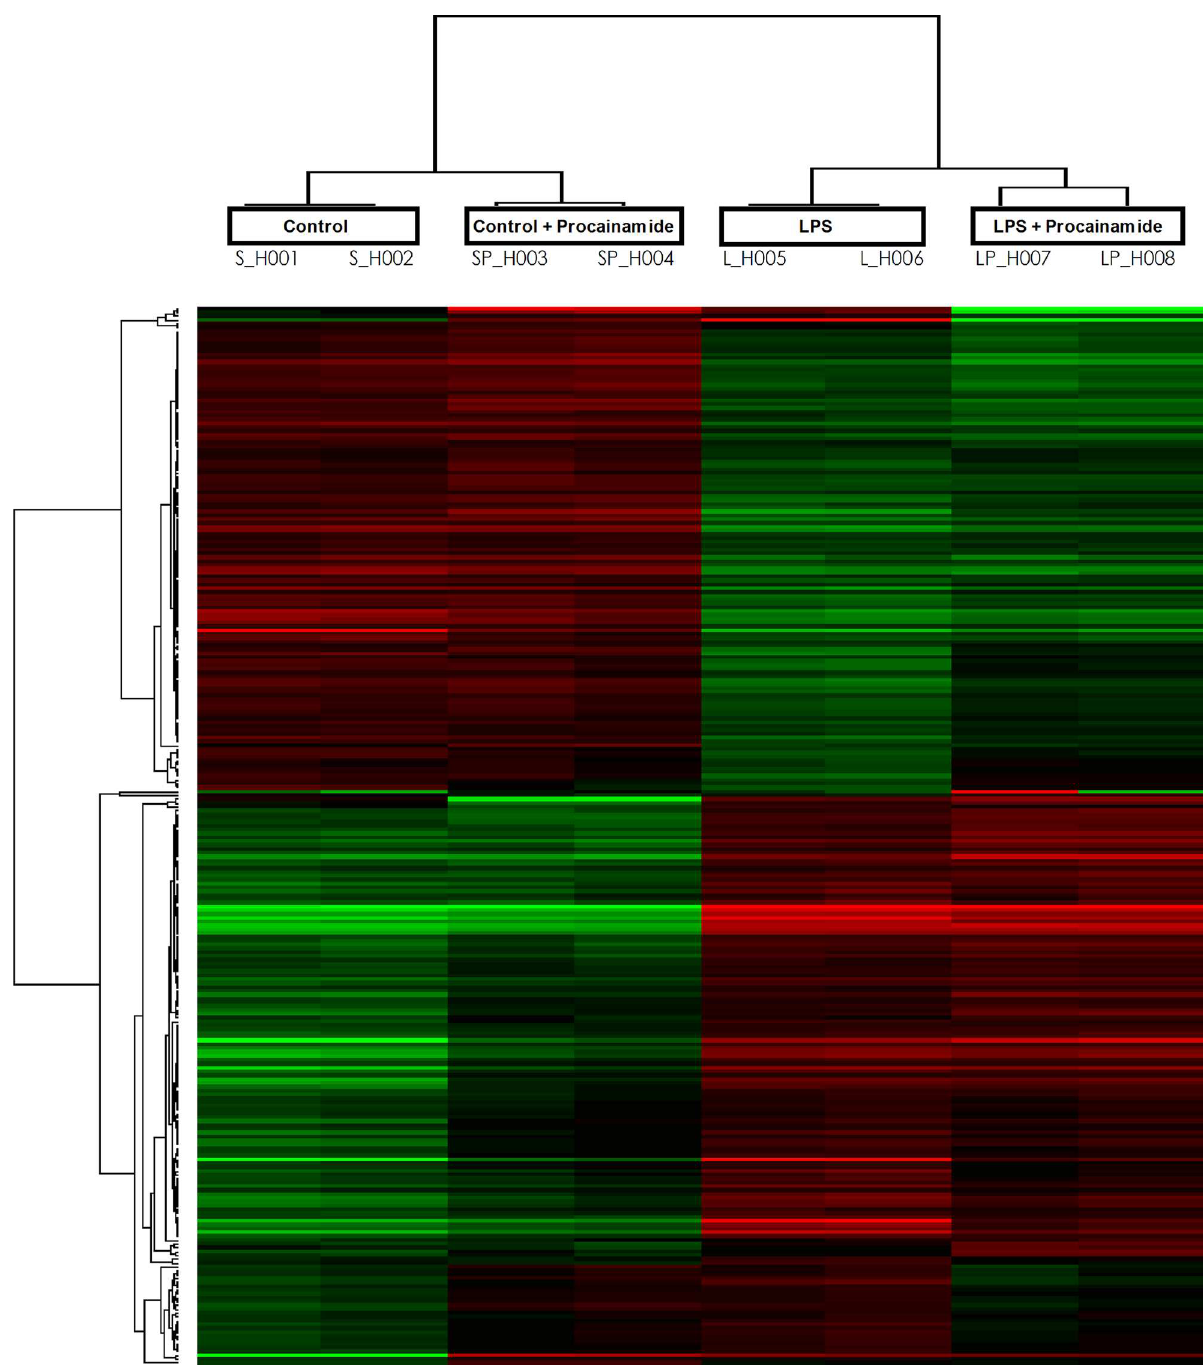
Fig 11. Clustered display of microarray data from lung tissue. Depicted are the changes in different groups of animals that received salineat time 0 (Control), received saline as in Control group and then received hydralazineat 0.5 h (Control + Hydralazine), received LPS at time 0 (LPS), and received LPS at time 0 and then received hydralazine at 0.5 h (LPS + Hydralazine). Up-regulated and down-regulated genes are symbolizedin red and green colors, respectively.